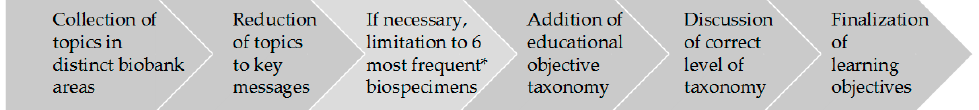
Figure 1. Flow chart of the process of the development of learning objectives. The * indicates the six most frequent biospecimens stored in partner biobanks of the German Biobank Alliance.